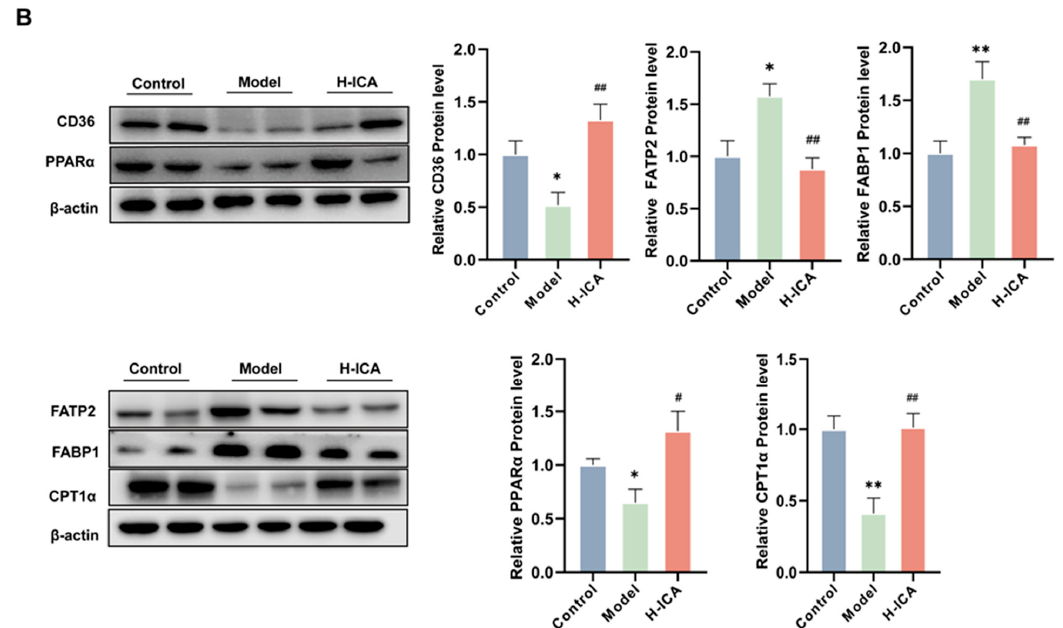
Figure 4. Icariin improves NAFLD in PCOS by promoting fatty acid oxidation in the liver. Gene and protein levels were verified. Gene expression (GAPDH as internal reference) ( A ); Protein expression ( β -actin as internal reference) ( B ). n = 6, values are mean ± SEM; Control vs. Model * p < 0.05, ** p < 0.01, # (Model vs. drug group), # p < 0.05, ## p < 0.01. 2.5. Icariin Alleviates NAFLD in PCOS by Increasing CD36 Content in Mitochondria Fatty acid transporter CD36 (CD36) is a membrane glycoprotein that facilitates long-